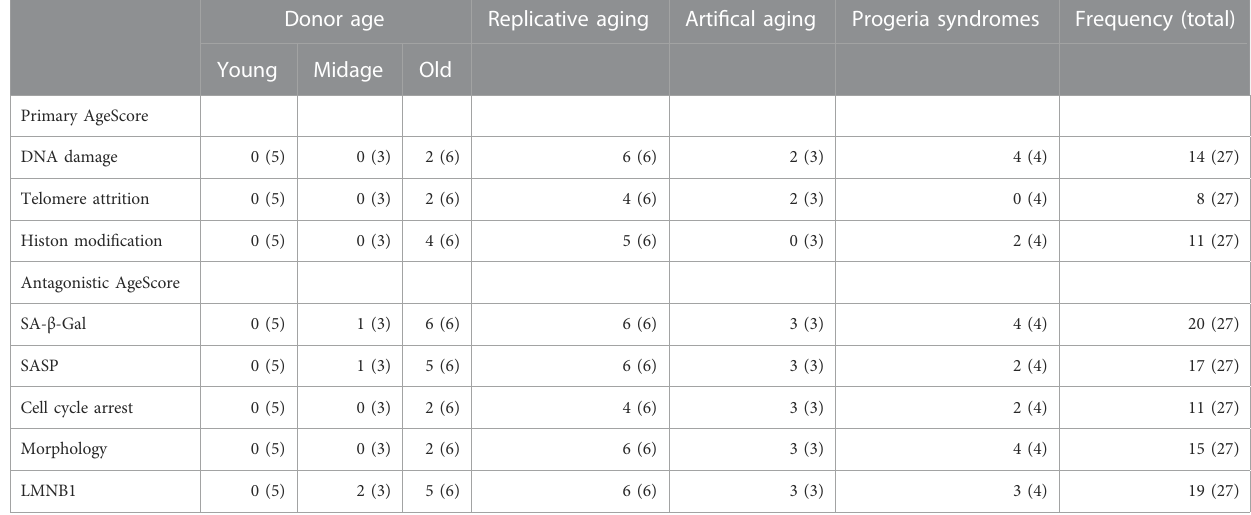
TABLE 2 Frequency of age marker expression per cell line investigated. Depicted is the frequency of the investigated primary and antagonistic age marker expression in the respective condition. Depicted are amount of positively tested cell lines and in brackets the total number of investigated cell lines per marker conditions,